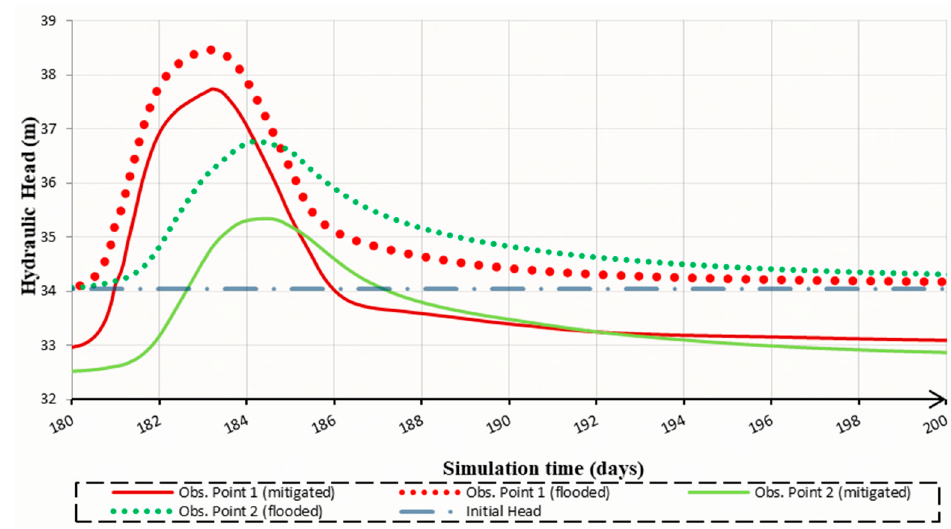
Figure 8. Comparison of mitigated (well) and flooding scenario. Time period was considered to be 180–200 days.